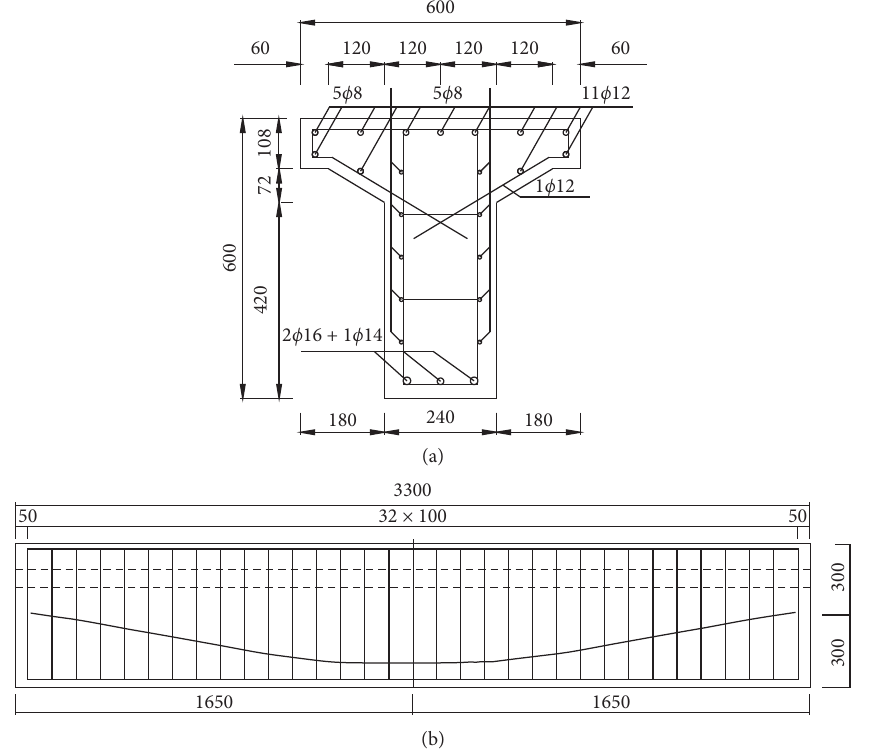
Figure 1: Layout of specimens. (a) Traverse section. (b) Longitudinal section.